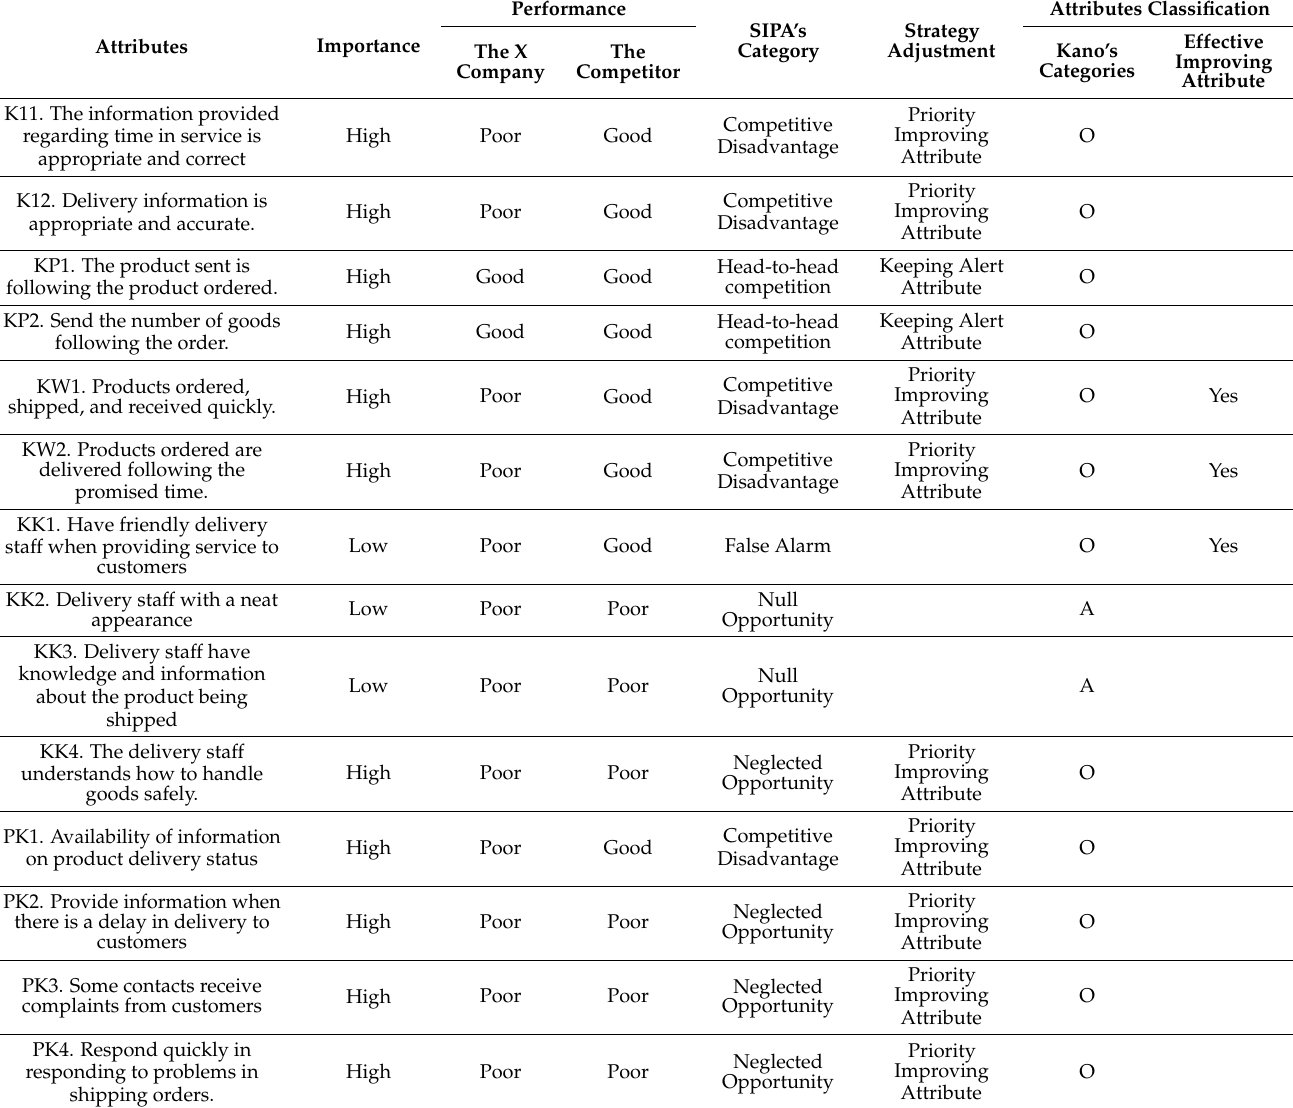
Table 10. Grouping of service attributes using SIPA